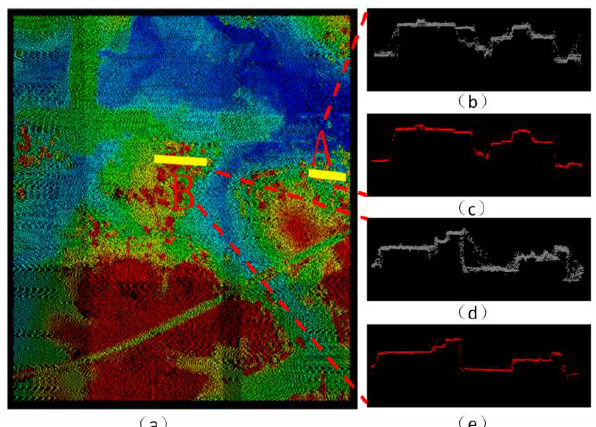
Figure 5. Cross section of dataset 1 before and after merging. (a) Overview of dataset 1, where Area A and Area B are two areas used to show the merging results; (b) Cross section of Area A before merging; (c) Cross section of Area A after merging; (d) Cross section of Area B before merging; (e) Cross section of Area B after merging.